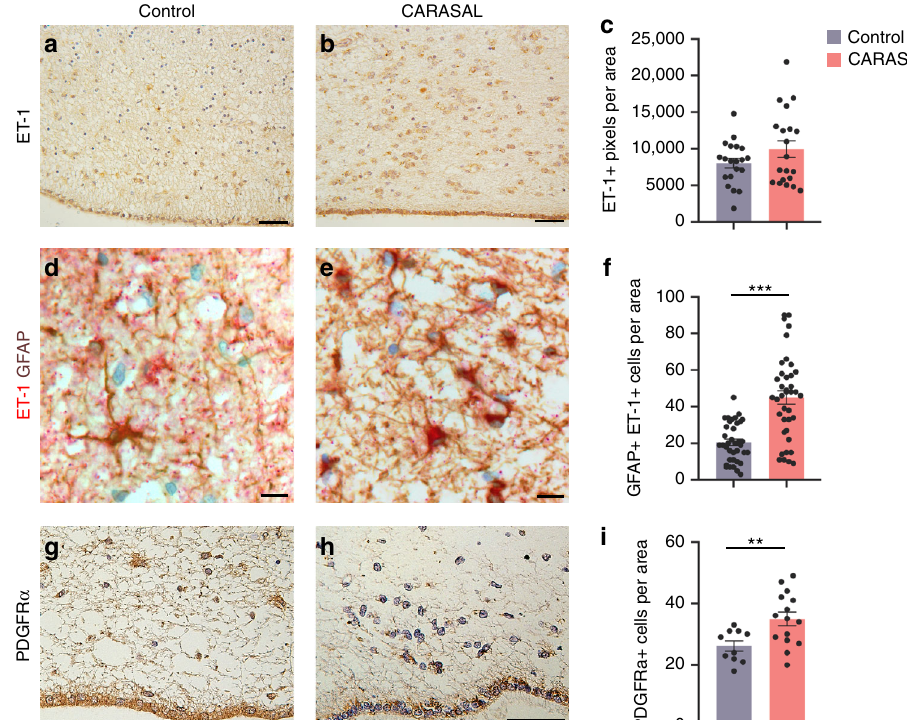
Fig. 8 ET-1 protein is increased in the SVZ of adult CARASAL patients. a, b ET-1 staining in the adult human SVZ of CARASAL patients and age-matched controls. Scale bars = 50 μ m. c Quanti fi cation of the number of ET-1 + pixels in the SVZ ( n = 20 images of the SVZ of two control and two